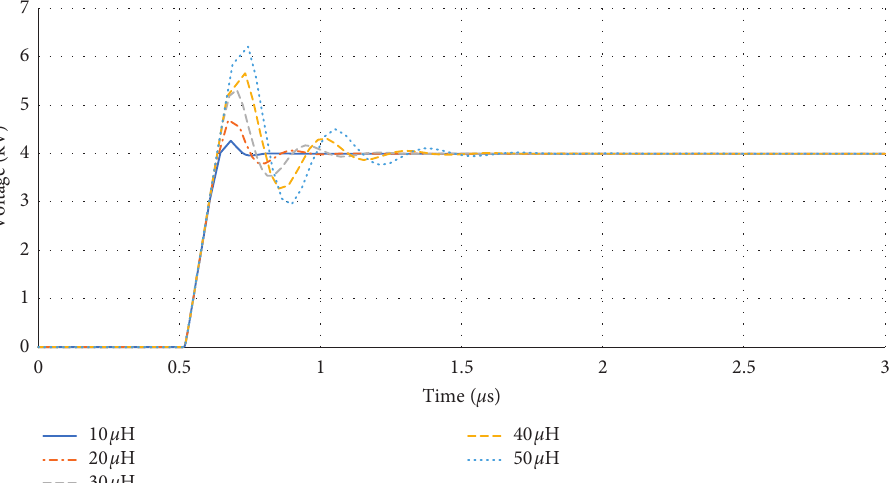
line on the output pulse.